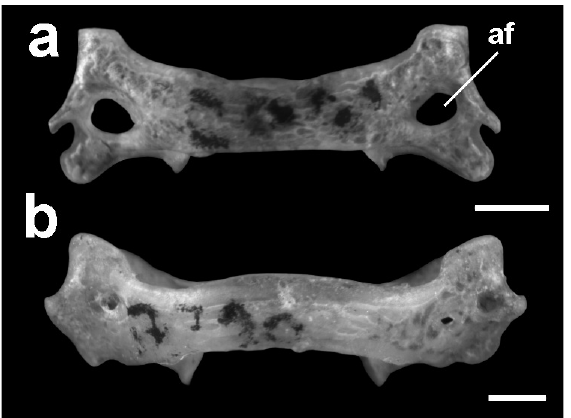
Figure 3 - Dorsal view of atlas: a ) Anoura caudifer : very large atlantal foramen; b ) Diaemus youngi : atlantal foramen with two openings. Acronyms: af: atlantal foramen. Scale bar represents 1